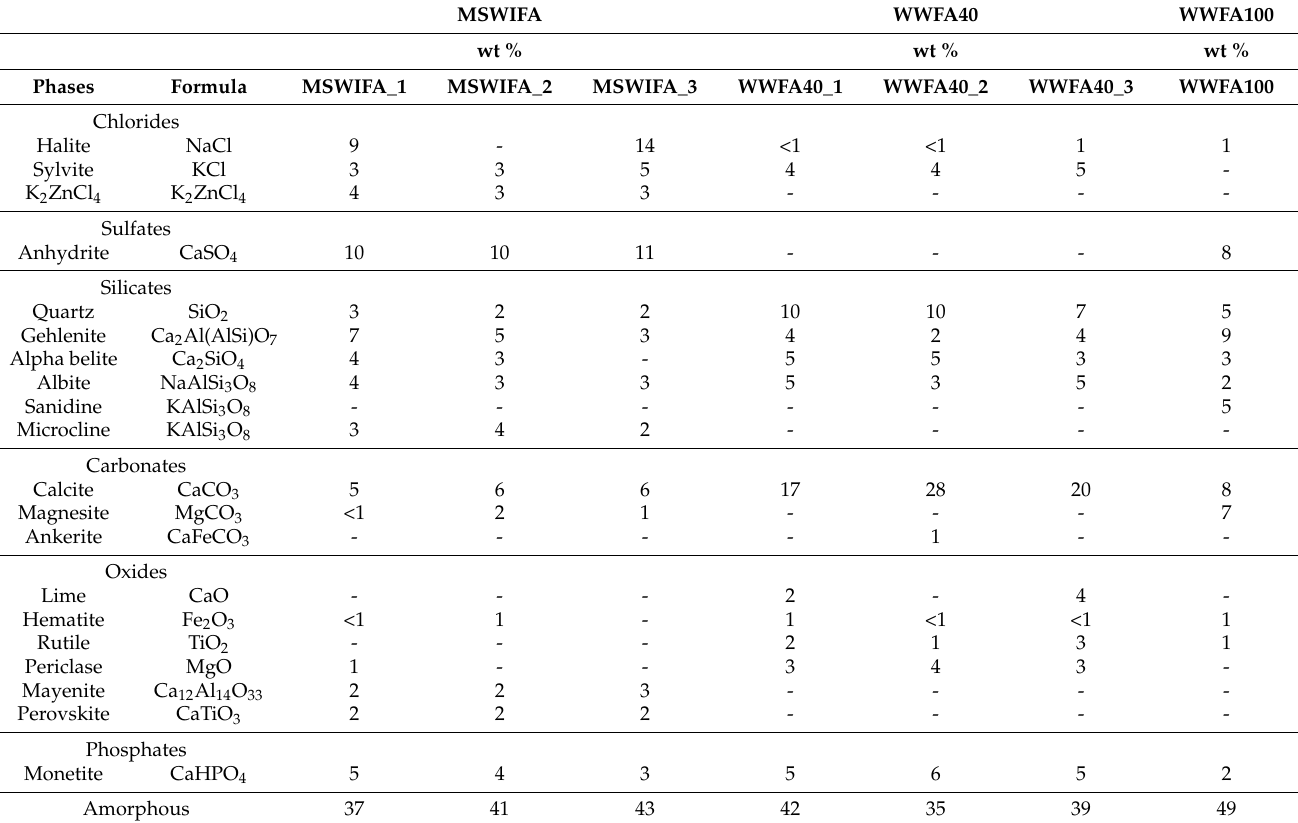
Table 3. Mineralogical composition of the analyzed MSWIFA, WWFA40 and WWFA100, determined by